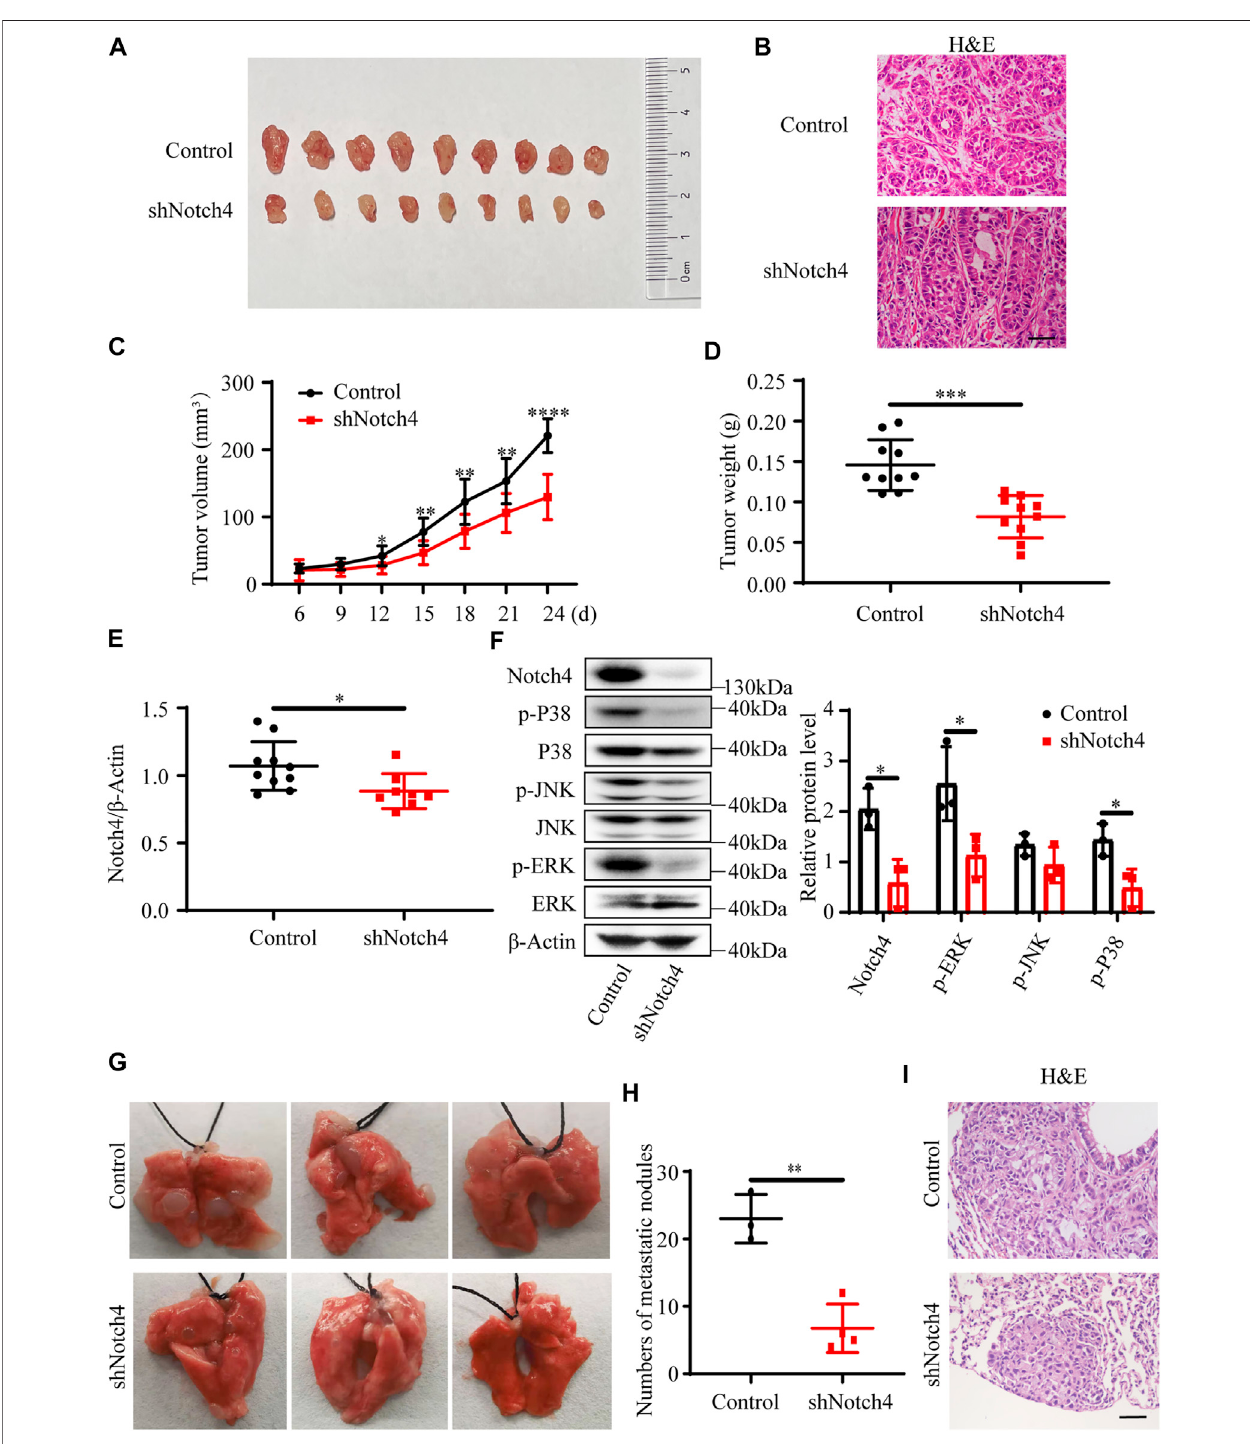
FIGURE 2 | Notch4 gene silencing alleviated xenograft tumor growth and metastasis. (A – F) Xenograft tumor growth experiments were performed in nude mice with A549-control and A549-shNotch4 stable cells. (A) Representative images of subcutaneous tumor dissected from the nude mice were presented. (B) Representative H&E staining images in sections of tumor were presented. Magni fi cation, × 200; Bar, 50 μ m. (C) Subcutaneous tumor growth curves of the nude mice were presented. ( n (cid:2) 10). (D) Subcutaneous tumor weights were presented. ( n (cid:2) 10). (E) The mRNA level of Notch4 in xenograft tumor. ( n (cid:2) 8 – 10). (F) The protein levels of Notch4, p38, p-P38, JNK, p-JNK, ERK, p-ERK in xenograft tumor. ( n (cid:2) 3). (G, I) Lung metastasis experiments were performed in nude mice with A549-control andA549-shNotch4stablecells. (G) Representativeimagesoflungmetastaseswerepresented. (H) Thenumbersofvisiblemetastaticnodulesinthelungsofmicewere counted.( n (cid:2) 3 – 4). (I) RepresentativeH&Estainingimagesinsectionsoflungtissueswerepresented.Magni fi cation, × 200;Bar,50 μ m.Datawerepresentedasmeans ± SD. * p < 0.05, ** p < 0.01, *** p < 0.001, **** p < 0.0001. H&E, hematoxylin-eosin staining. JNK, c-Jun N-terminal kinase; ERK, extracellular signal-regulated kinase.